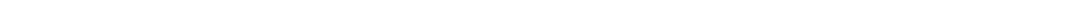
Figure 2: Influence of angiotensin-converting enzyme inhibitors (ACEIs) or angiotensin-II receptor blockers (ARBs) used as hyper- tension medication on increased susceptibility to and mortality in SARS-CoV-2 infection. (1) Blocking renin-angiotensin-aldosterone system with ACEIs or ARBs reduces renal acid elimination, leading to increased ventilation to maintain acid-base balance. This process also (2) increases opportunity for SARS-CoV-2 to interact with respiratory system and (3) increases angiotensin-converting enzyme 2 (ACE2) ex- pression in respiratory epithelial cells, the target of SARS-CoV-2 to gain access to our body. (4) Inflammatory responses in the respiratory sys- tem aiming to eliminate SARS-CoV-2 result in generation of more acidic metabolic wastes, which together with increased respiratory muscular work leads to the development of metabolic acidosis. (5) Metabolic acidosis compromises adaptive cellular immunity and (6) inefficient eradi- cation of SARS-CoV-2 may predispose to the generation of cytokine